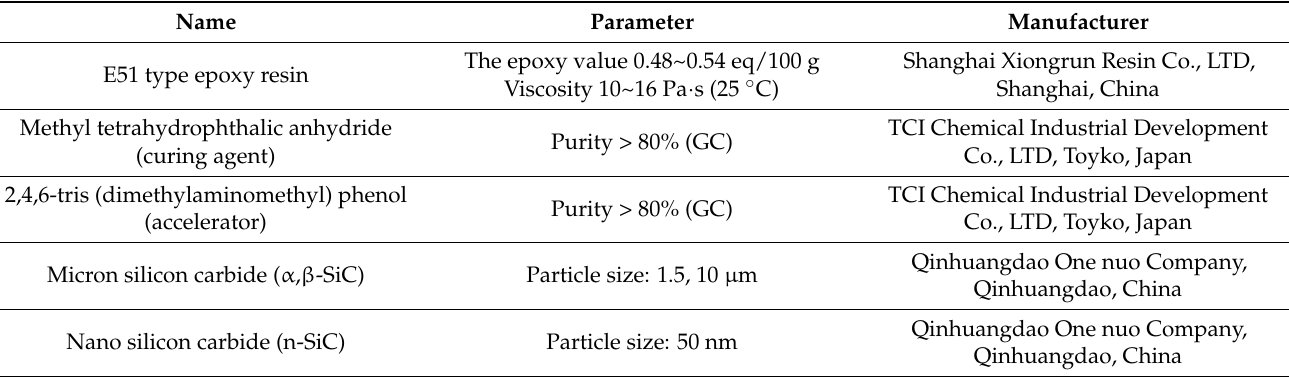
Table 1. Information of the raw